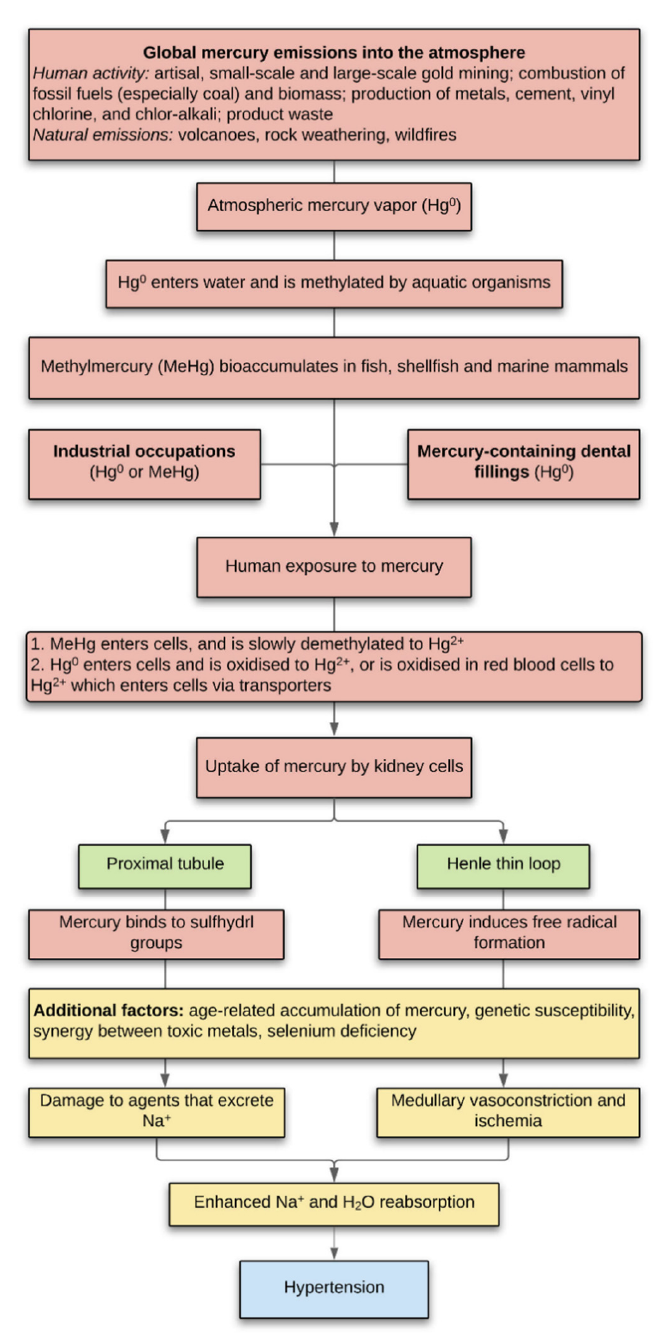
Figure 6. Potential mechanisms of kidney mercury-induced hypertension. Exposure to mercury results in organic and inorganic mercury being taken up by the cells of proximal tubules and/or Henle thin loops. In proximal tubules of the cortex, mercury-initiated damage to agents that excrete sodium in response to elevated blood pressure (for example by selective binding of mercury to sulfhydryl-rich proteins) would enhance sodium reabsorption. In the medulla, free radicals induced by mercury in Henle thin loops could result in medullary ischemia, also with enhancement of sodium reabsorption. Both or either of these cortical and medullary mechanisms would increase sodium and concomitant water reabsorption, with resultant hypertension. Mercury toxicity would be accentuated by bioaccumulation of mercury over time, genetic susceptibilities to mercury toxicity, the presence of other heavy metals, or deficiencies in mercury-protective mechanisms such as